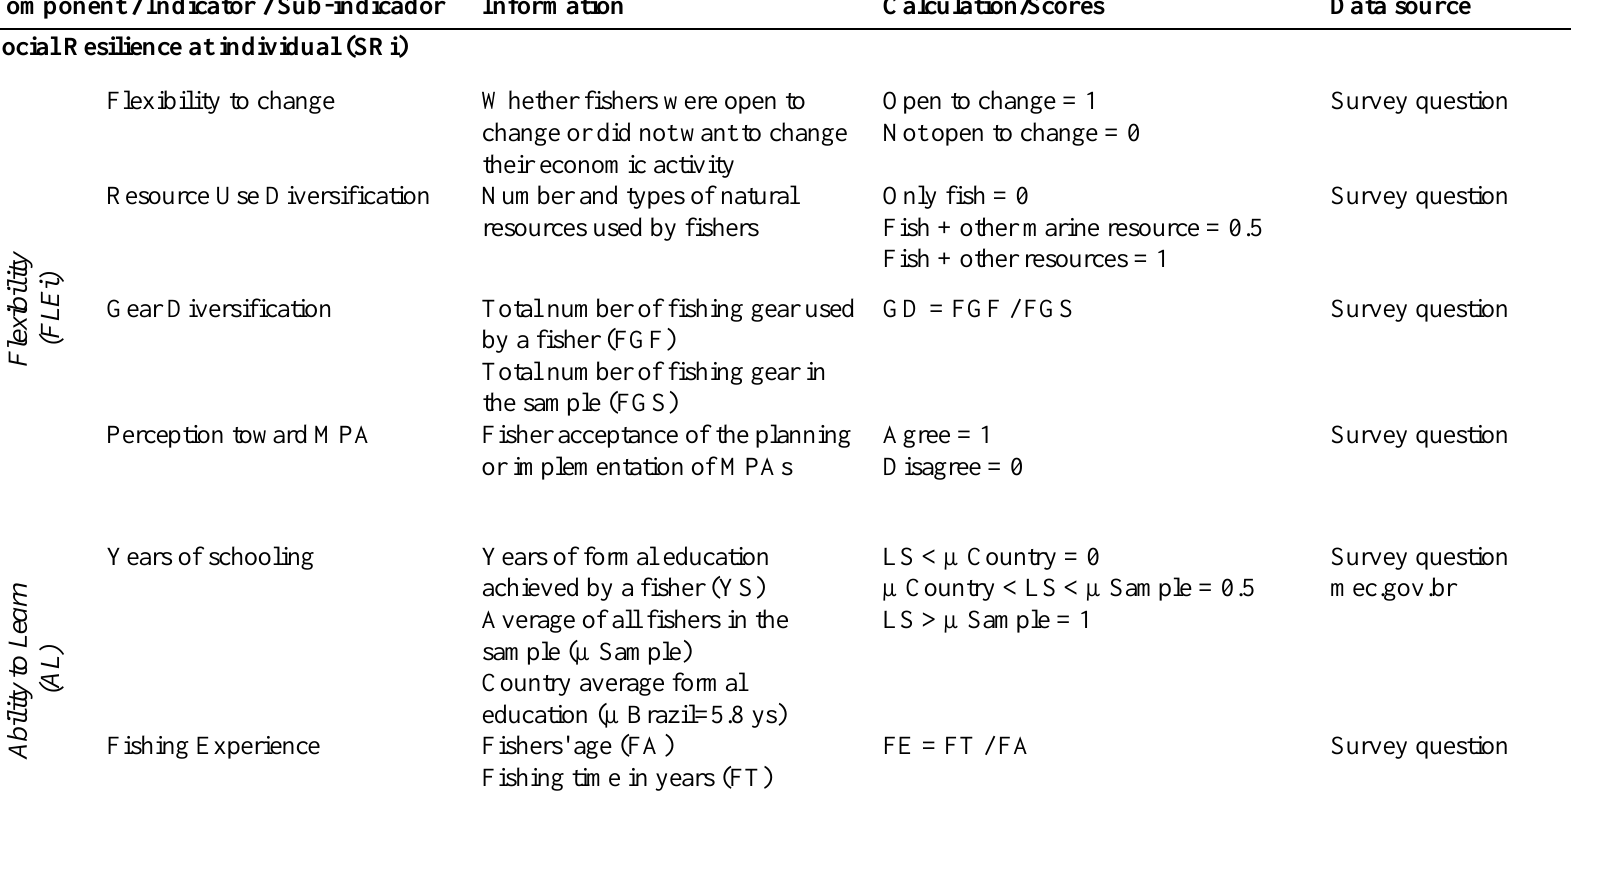
Table A2.1: Information used to calculate the Social-Ecological Resilience Index (SERI) of fishers, including components, indicators and sub-indicators. The specified data source is provided for each sub-indicator. RDSE Ponta do Tubarão = State Sustainable Development Reserve Ponta do Tubarão; RESEX Batoque = Extractive Reserve Batoque; RESEX Canto Verde = Extractive Reserve Prainha do Canto